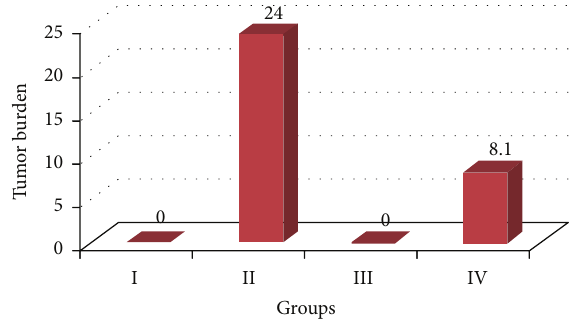
Figure 4: Variations in LPO levels after DENA/CCl 4 induced hep- atic carcinogenesis with/without ACE administration. Significance level—normal versus carcinogen treated control; carcinogen treated control versus ACE treated experimental ∗ 𝑃 < 0.001 .